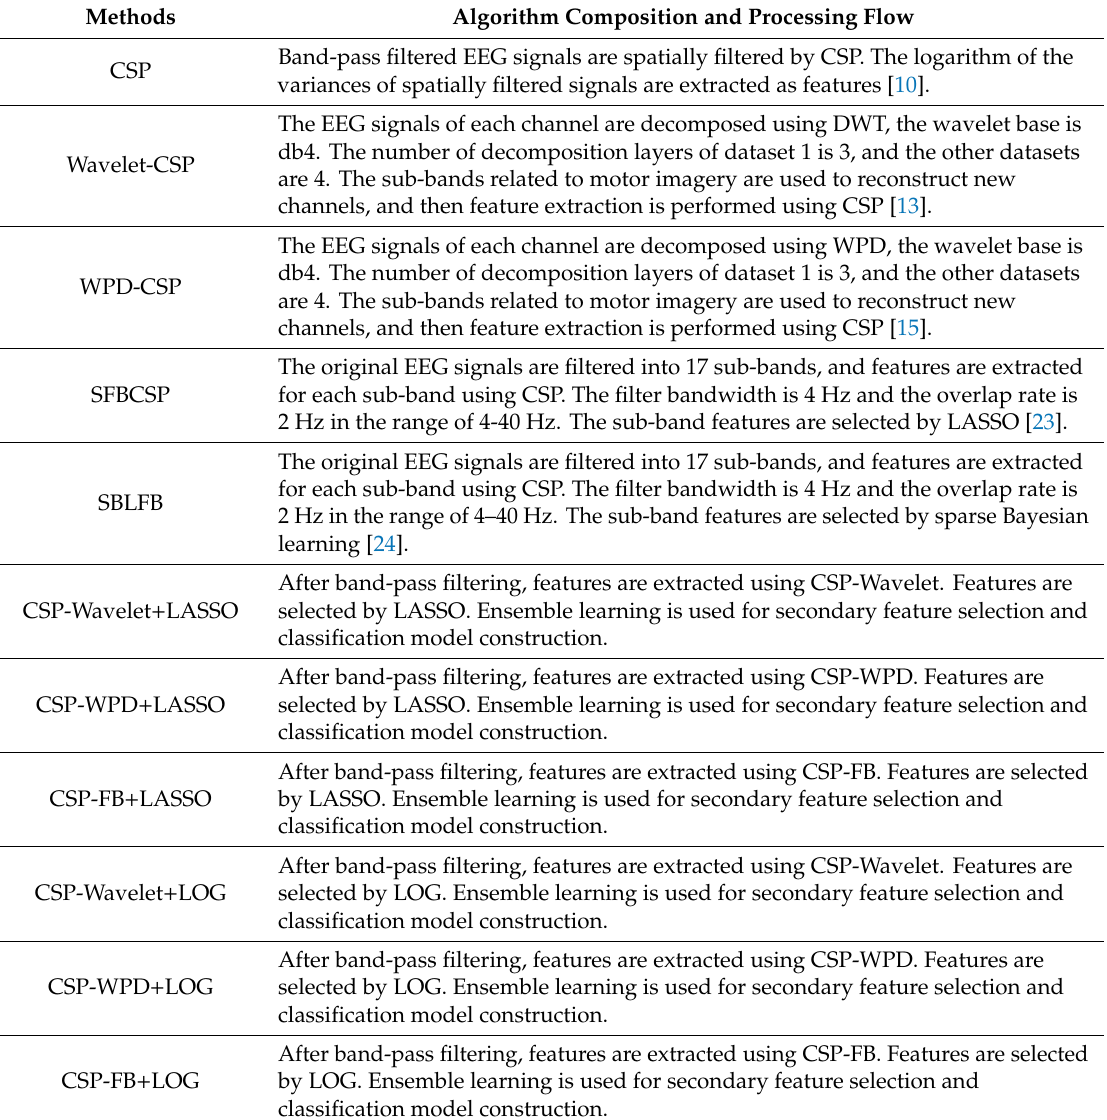
Table 1. Compared